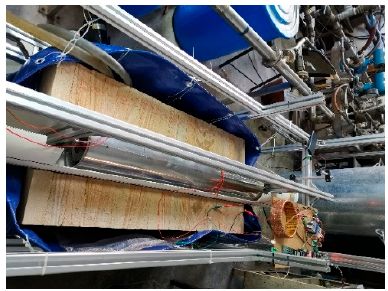
Figure 20. Experimental setup of well logging experiment.